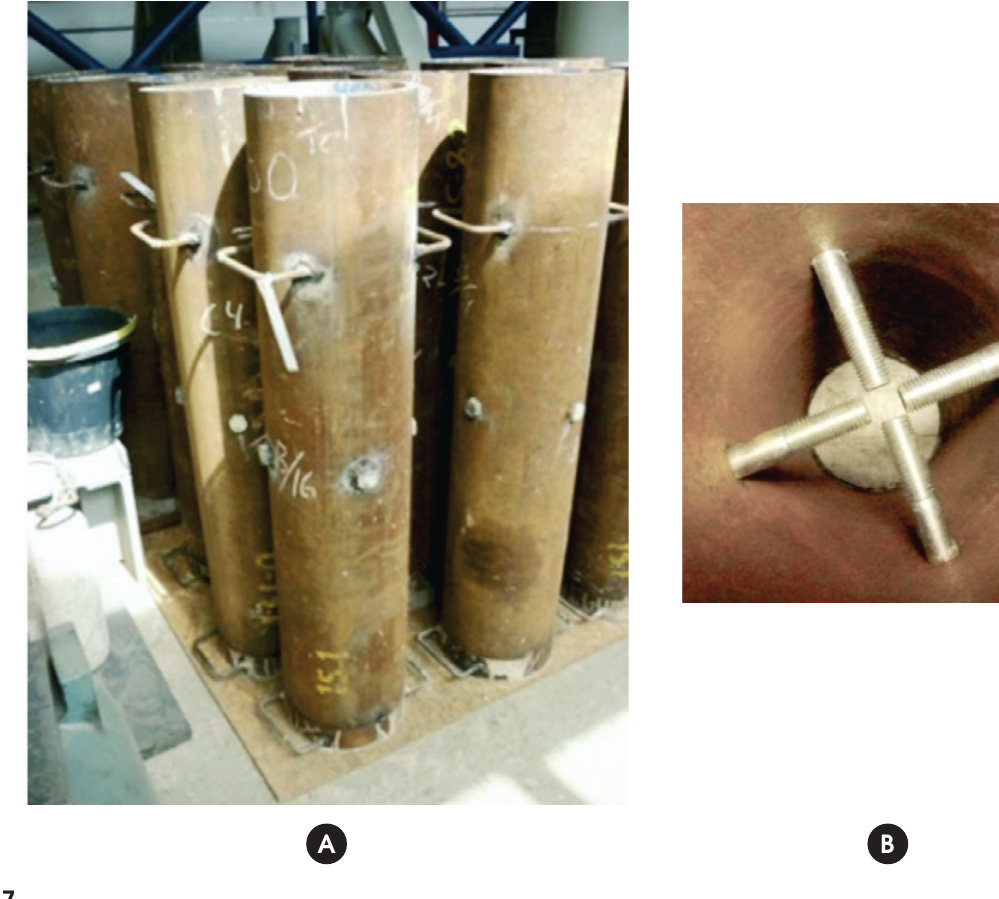
Preparation of models of the serie A to concreting